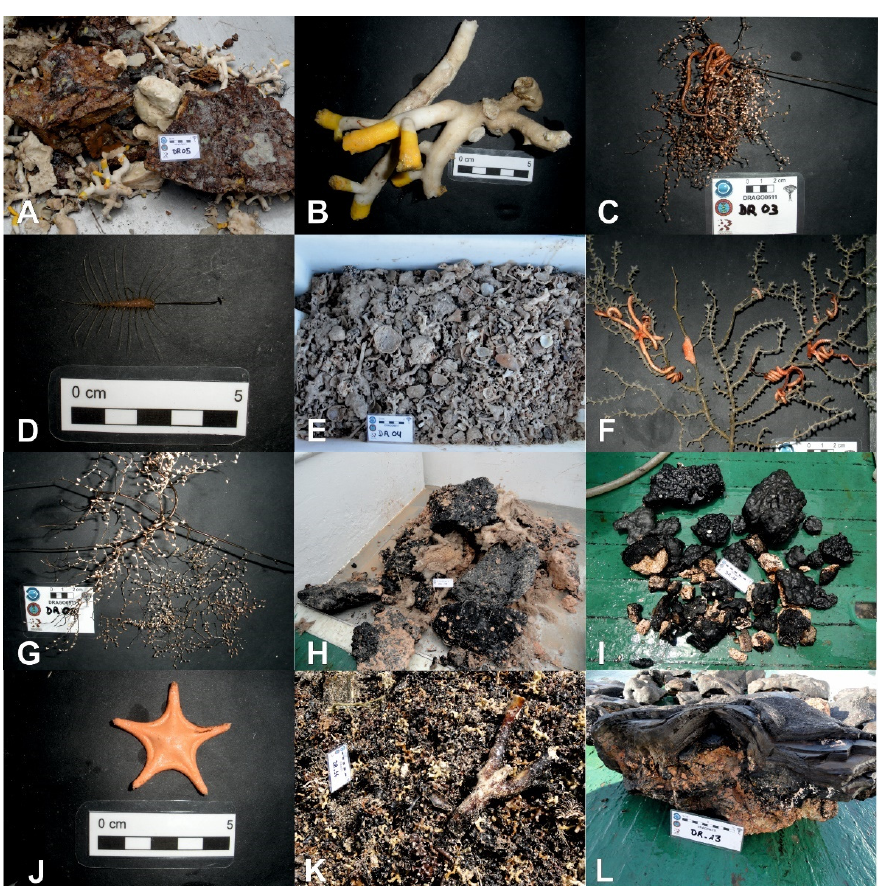
Figure 11. Images of some samples obtained during the DRAGO0511 expedition [48] in the Echo ( A – E ), The Paps ( F – J ), Tropic ( K ) and Drago ( L ) seamounts at the Canary Islands Seamount Province. ( A ): Rocks, sponges and corals; ( B ): A living colony of the scleractinian Dendrophyllia cornigera collected at the summit; ( C ): A gorgonian ( Metallogorgia melanotrichos ) harboring an euryalid ophiuroid collected at the flank; ( D ): A small antipatharian ( Bathypathes ) collected at the flank; ( E ): Coral rubble retrieved from the SE flank; ( F ): Holaxonian gorgonian with abundant epibionts captured at the summit; ( G ): Metallogorgia gorgonian collected at the summit; ( H ): Fe-Mn crusts and hexactinellid sponges retrieved from the summit; ( I ): Fe-Mn crust samples obtained at the flank; ( J ): Goniasterid starfish collected at the flank; ( K ): Coral rubble of scleractinians (mainly Solenosmilia variabilis and Desmophyllum -like cup corals) collected at the eastern; ( L ): Thick Fe-Mn crust on volcanoclastic rock substrate retrieved from the summit.